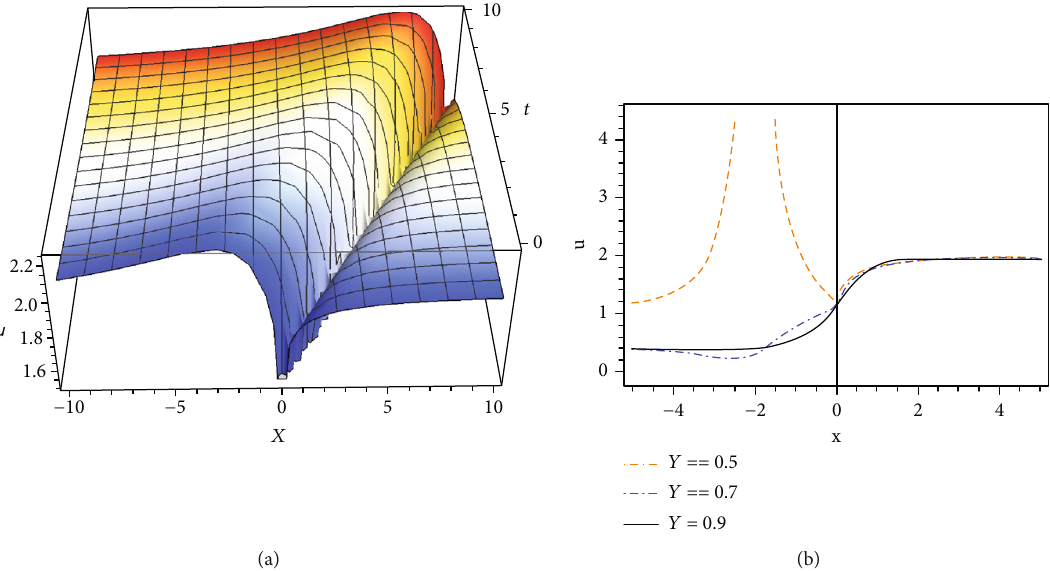
j . (a) The 3D graph of u 5,1